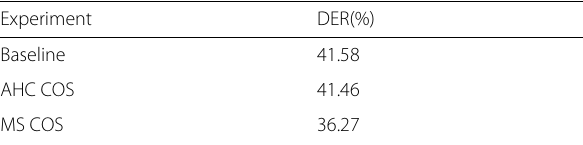
Table 4 DER(%) results for the unsupervised adaptation